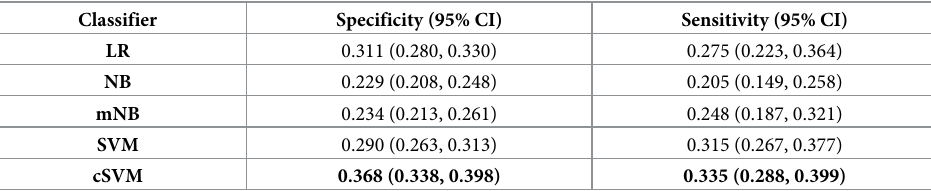
Table 3. Performance comparison at operating points corresponding to high sensitivity and specificity.